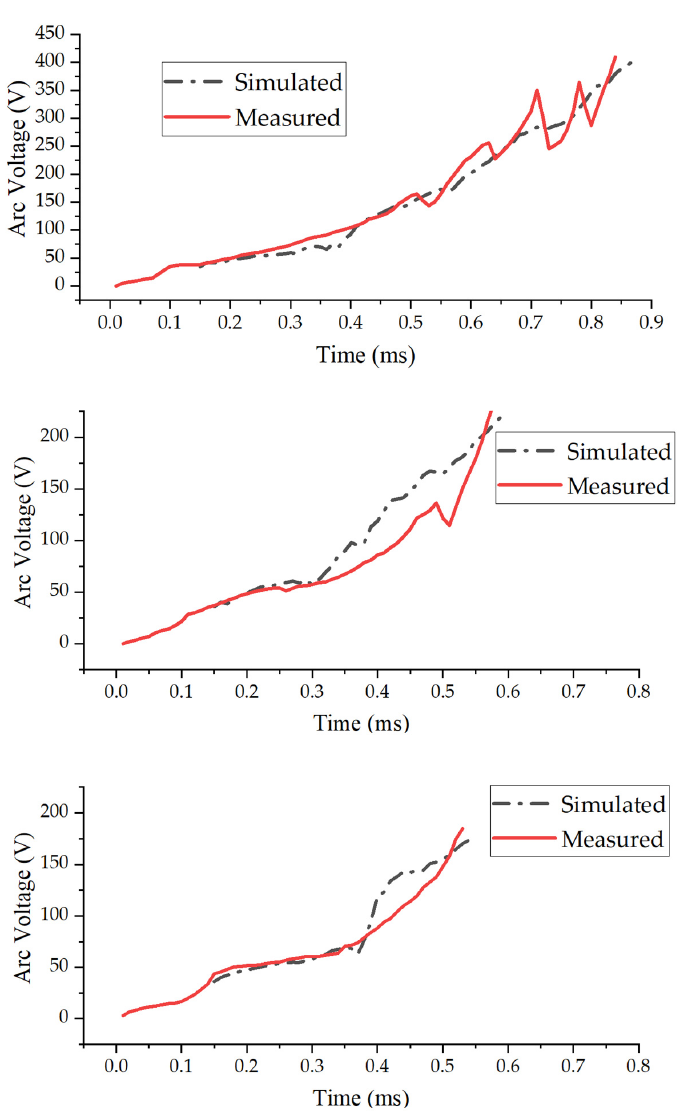
Figure 12. Comparison diagram of arc voltage simulation and experiment.